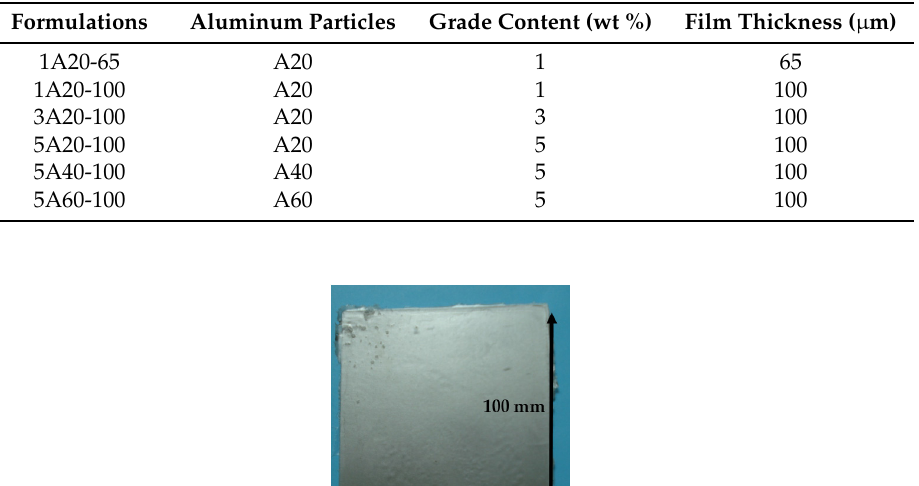
Table 2. Films prepared in this study.